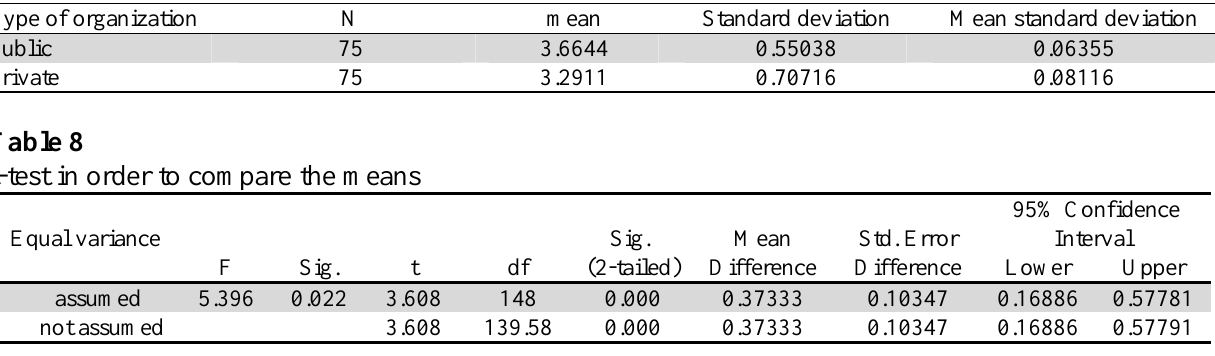
Mean and standard deviation of managers of the public and private organizations' ethical tendency towards the social and environmental activities